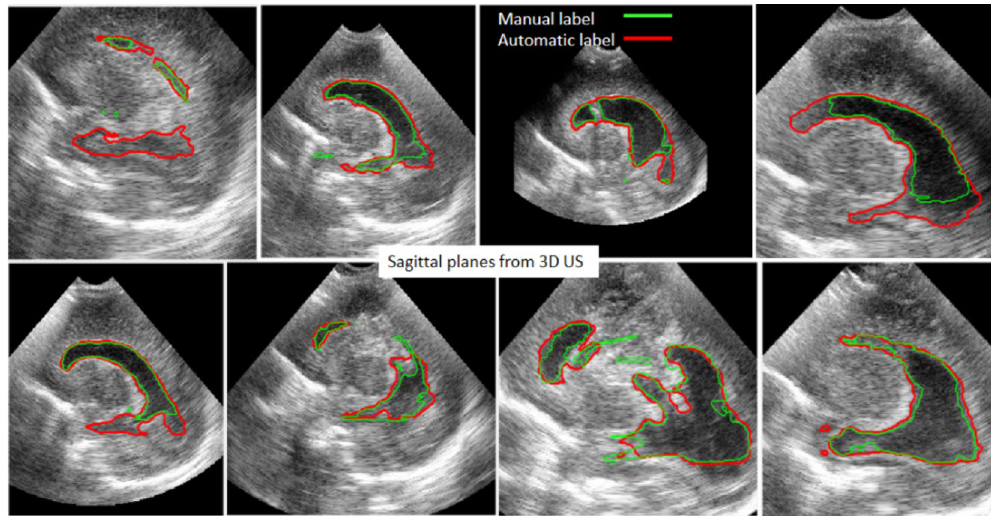
Figure 1. A series of representative sagittal planes extracted from different 3D US of different patients. The contours were measured manually (in green) and using the automatic deep-learning approach (red) one slice at a time. The contours measured automatically were obtained by training the CNN with the manual labels. The large differences seen in several images explain the low value of the IoU metrics. The automatic contours are more accurate.